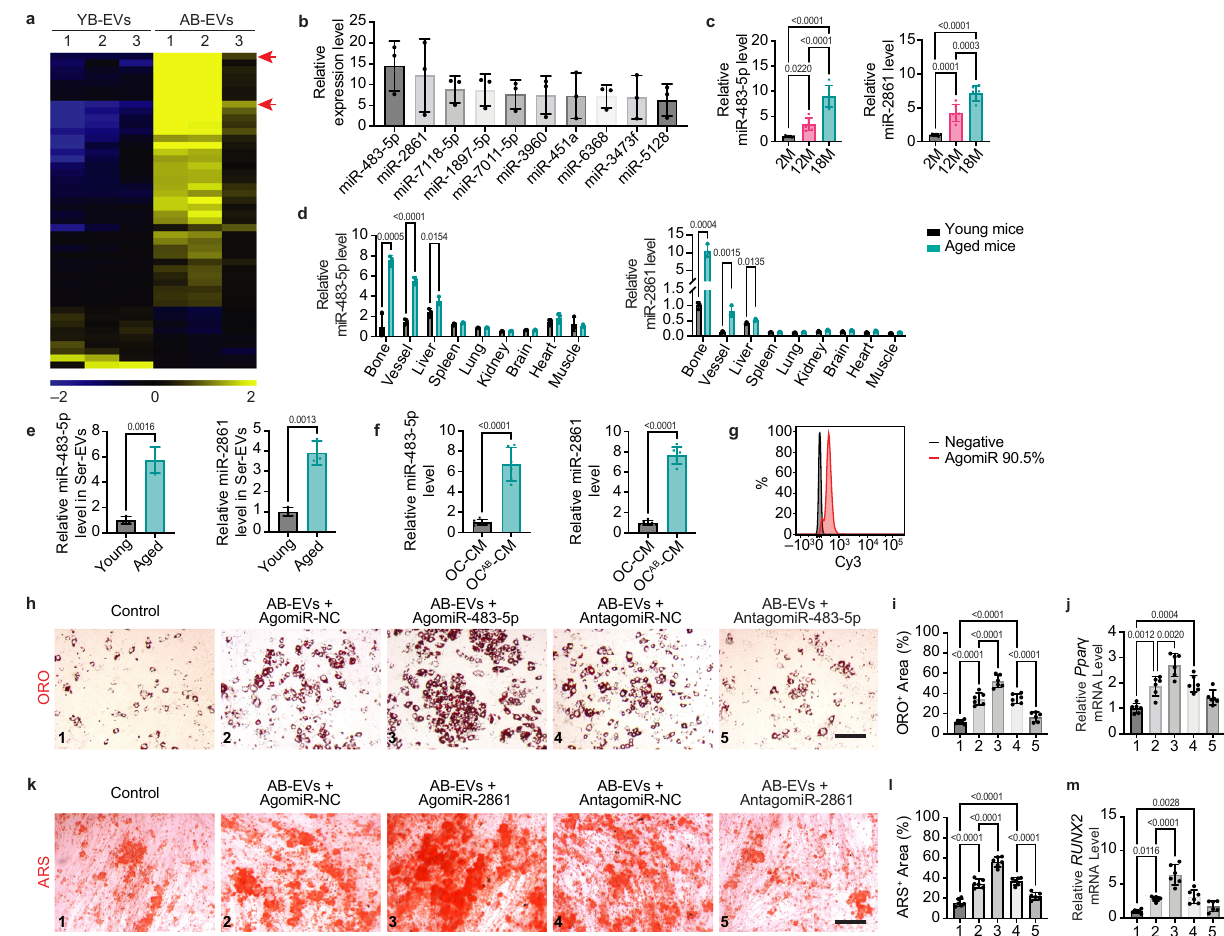
Fig. 6 miR-483-5p and miR-2861 are enriched in AB-EVs and responsible for the AB-EVs-induced promotion of adipogenesis of BMSCs and calci fi cation of VSMCs. a Heatmap showing the differentially expressed miRNAs (absolute fold change ≥ 1.5; P < 0.05) between AB-EVs and YB-EVs. n = 3 biologically independent samples per group. b Top ten most abundant miRNAs in AB-EVs relative to YB-EVs. n = 3 biologically independent samples per group. c-f , qRT-PCR analysis of miR-483-5p and miR-2861 expression in B-EVs from bone specimens of the mice at different ages ( c ; n = 6 biologically independent animals per group), in different tissues from 3-month-old or 18-month-old mice ( d ; n = 3 biologically independent animals per group), in Ser-EVs from young (27- to 31-year-old) or old (67- to 73-year-old) human donors ( e ; n = 3 biologically independent donors per group), and in OC-CM and OC AB -CM ( f ; n = 6 biologically independent samples per group). g , Flow cytometry histograms showing the presence of agomiR-NC-Cy3 indicator in AB-EVs. n = 3 biologically independent samples per group. h – j ORO staining images ( h ), quanti fi cation of the percentage of ORO + areas (red; i ), and qRT-PCR for Ppar γ expression ( j ) in BMSCs with different treatments under adipogenic induction. Scale bar: 50 μ m. n = 6 biologically independent cells per group. k – m , ARS staining images ( k ), quanti fi cation of the percentage of ARS + areas (red; l ), and qRT-PCR for RUNX2 expression ( m ) in VSMCs with different treatments under osteogenic induction. Scale bar: 50 μ m. n = 6 biologically independent cells per group. Experiments in a – g were performed with at least three biological replicates per group without independent repetition. The other experiments were repeated independently three times with similar results. The illustrated results represented one of the three independent experiments. Data were presented as mean ± SD. Statistical signi fi cance was determined by one-way ANOVA with Bonferroni post hoc test ( c , i – j , and i – m ) or unpaired, two-tailed Student ’ s t -test ( d – f ). Source data are provided as a Source Data fi le.